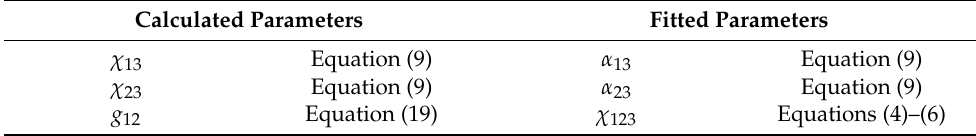
Table 4. Calculated physical parameters and fitting parameters use in the calculation procedure. Calculated Parameters Fitted